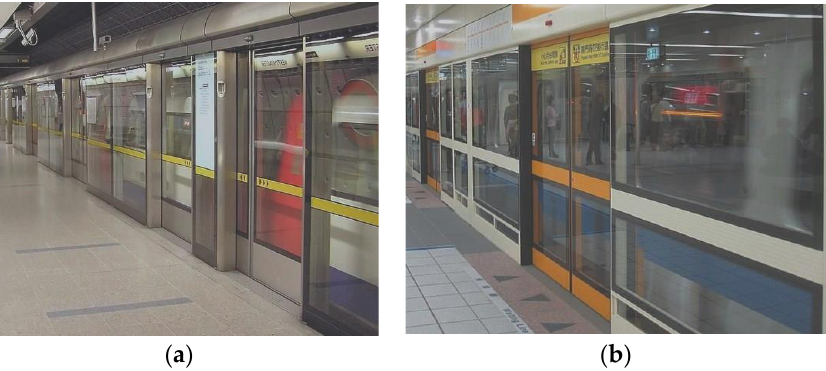
Figure 1. Practical PSDs with gaps on platforms. ( a ) single open door PSD; ( b ) double open door PSD.